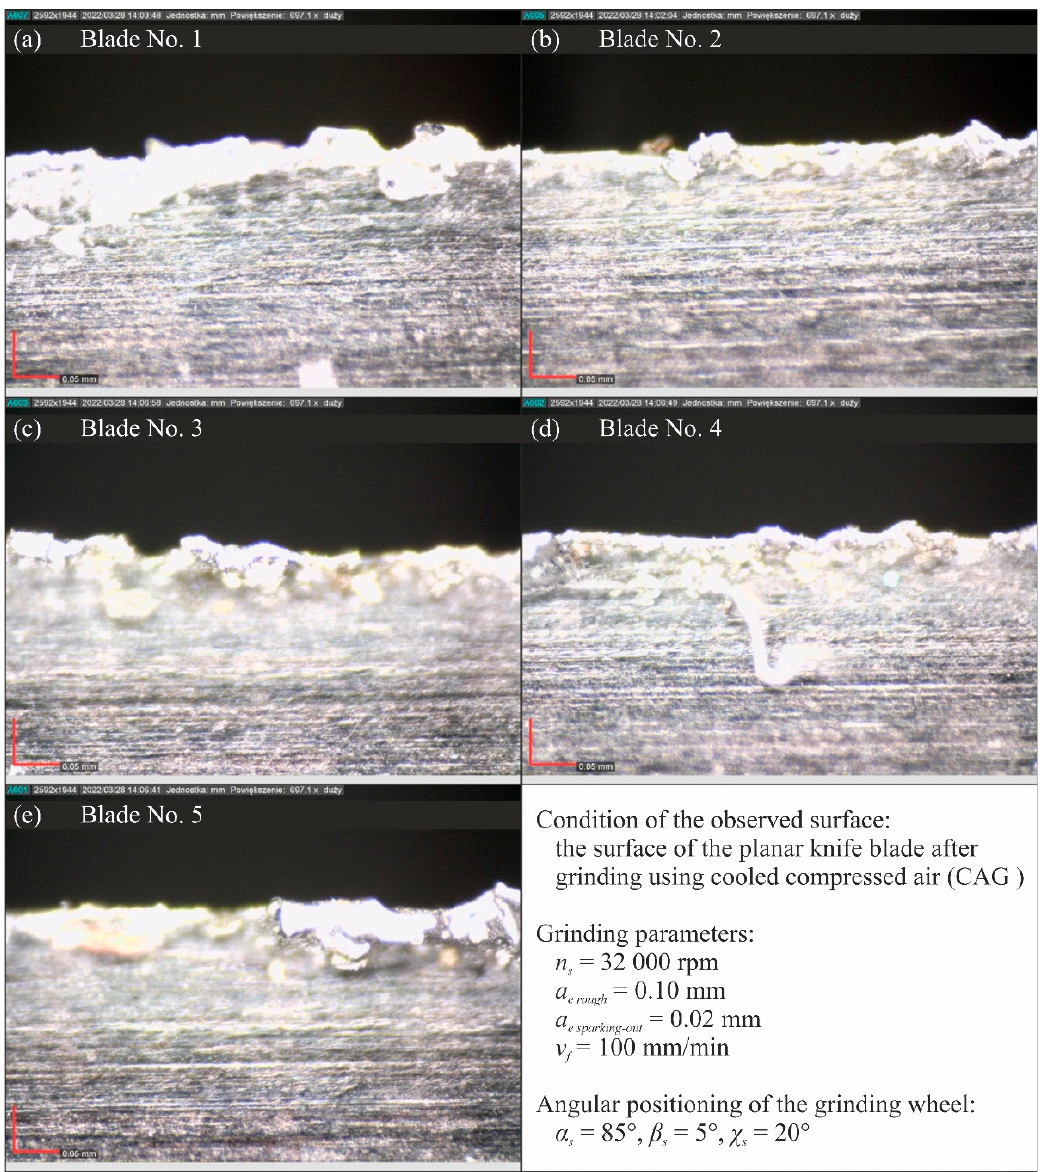
Figure 17. Microscopic views of the blade surfaces of five planar knives shaped using cooled compressed air (CAG) recorded with a Dino-Lite Edge AM7515MT8A digital measuring microscope from AnMo Electronics Corp. (New Taipei City, Taiwan, China) at a magnification of approximately 700×: ( a ) blade No. 1; ( b ) blade No. 2; ( c ) blade No. 3; ( d ) blade No. 4; ( e ) blade No. 5.